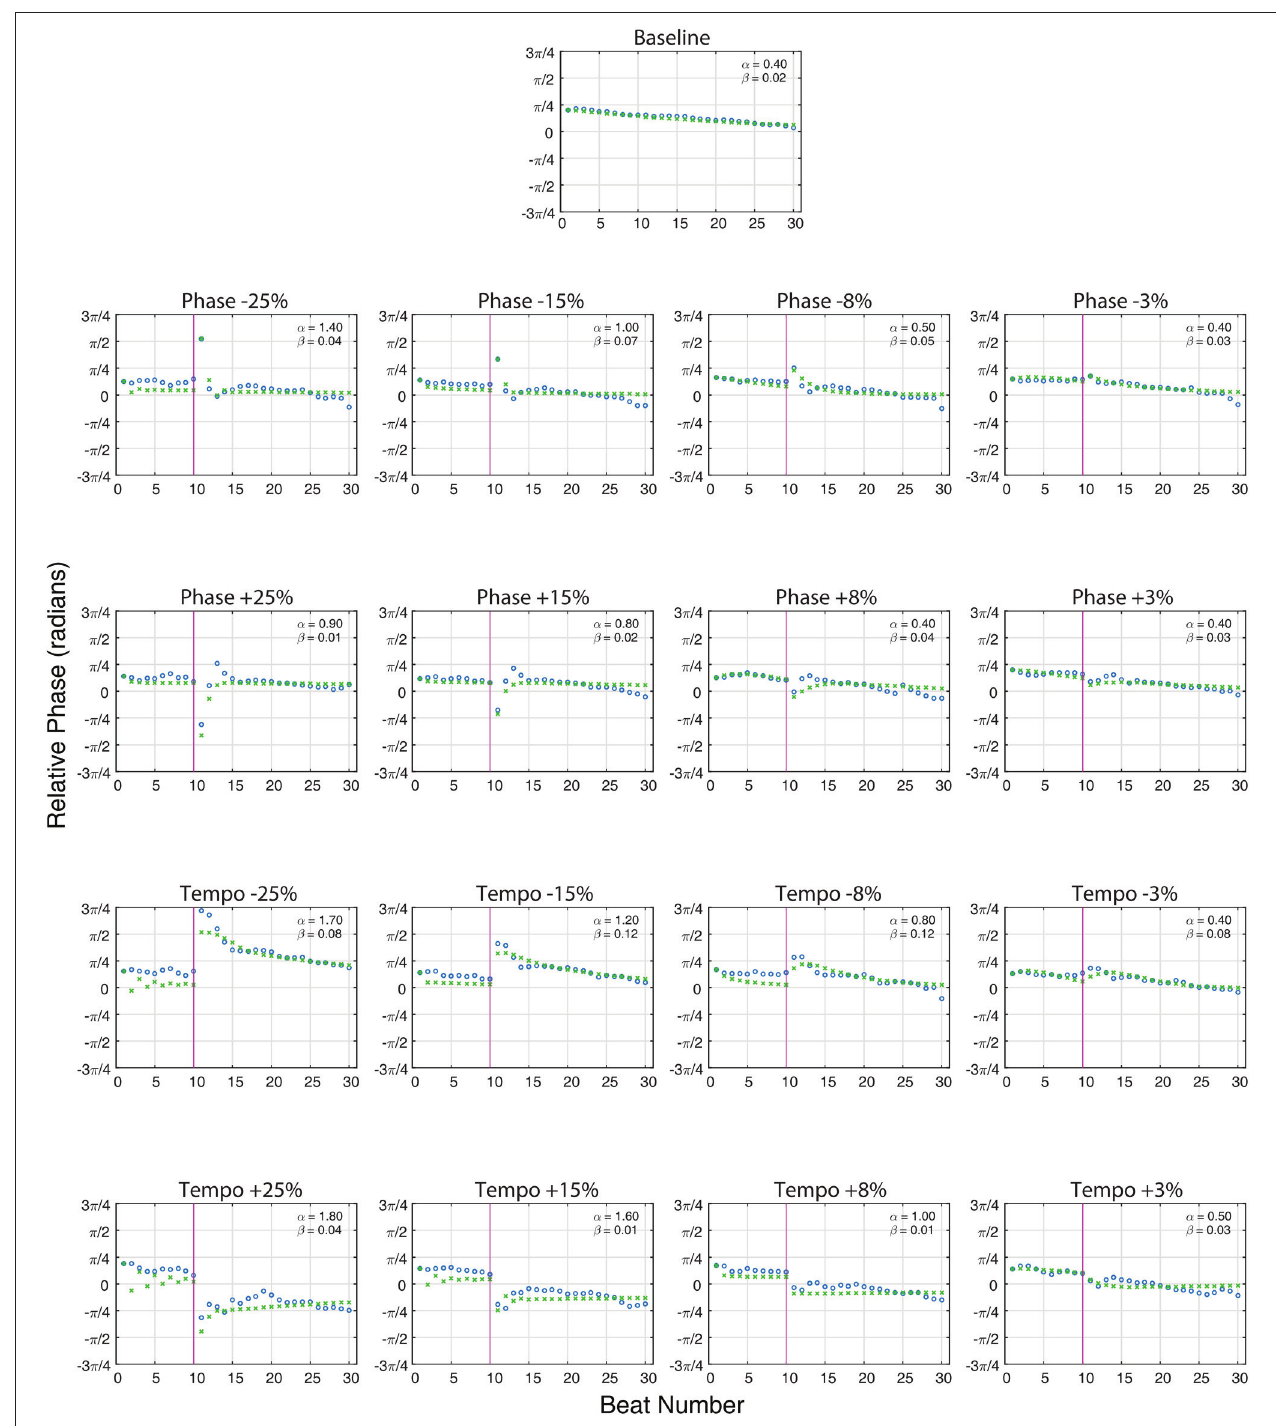
FIGURE 3 | The averaged relative phase in radians (Y-axis) over successive beats (X-axis) for averaged baseline trials ( n = 80 , top) and each averaged perturbation condition ( n = 10 per condition) at a base tempo of 85 bpm. Ronan’s results (circles) are plotted against the model predictions (x’s). The close alignment of the model predictions to the experimentally obtained values indicate that Ronan’s responses to these perturbations are consistent with the model of coupled oscillation. On perturbation conditions, the vertical line at 10 beats indicates the onset of the tempo or phase shift indicated at the top of the plot. Phase ( α ) and period ( β ) coupling factors are noted in the upper right portion of each